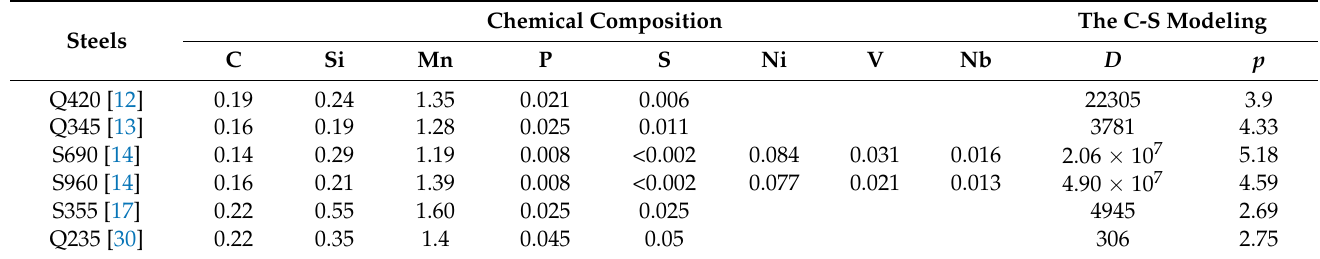
Table 3. Chemical composition and the C-S model parameters of different